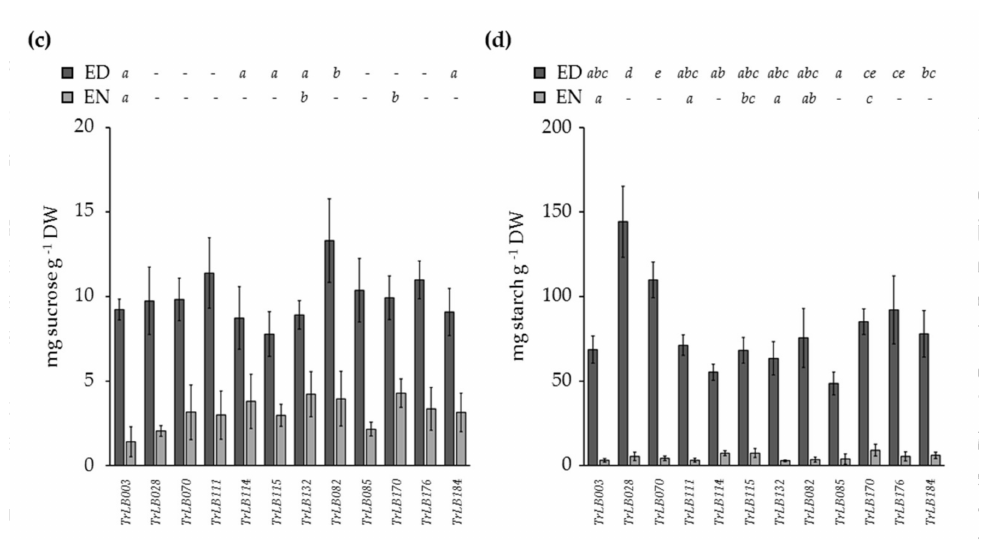
Figure 6. Diurnal leaf glucose ( a ), fructose ( b ), sucrose ( c ), and starch ( d ) contents in 12 selected genotypes. Ten clonal replicates of each of the 12 genotypes were harvested at ED and at EN. The letter pairs ( a – e ) indicate significant differences in NSC contents between genotypes ( p = 0.05) derived from analysis of variance and Tukey’s HSD post-hoc comparisons. For ( a – d ), a dash (–) was used to indicate no significant difference for example for ED glucose the dash (–) = abc . Error bars indicate 95% confidence intervals.